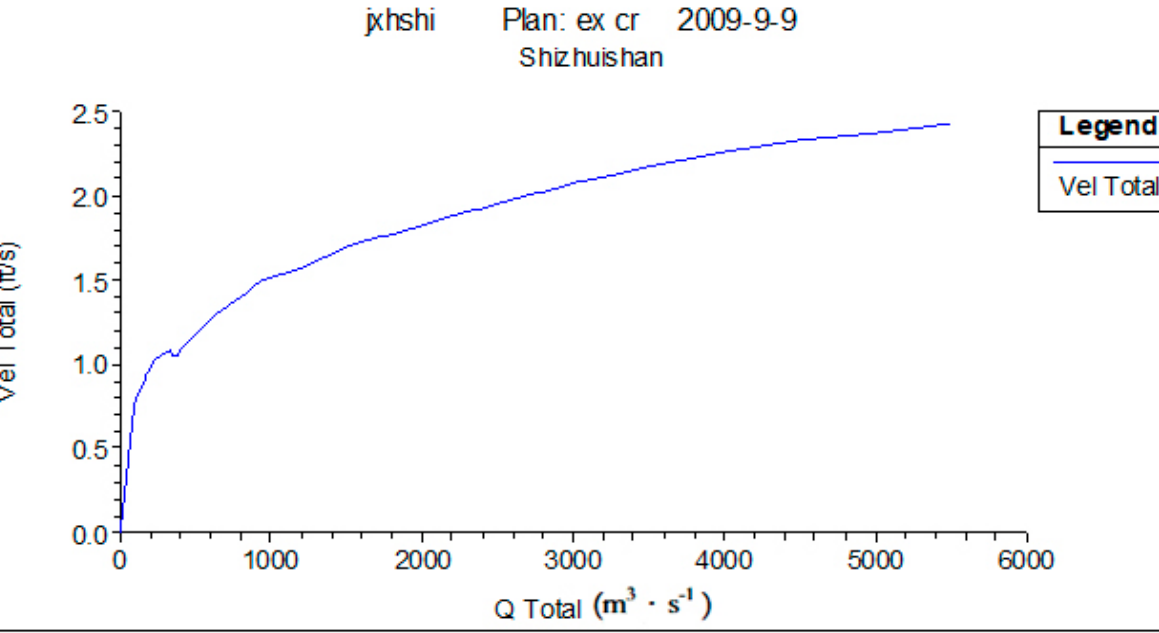
Figure 4. Flow velocity change at Shizuishan cross under different flows. Source: China Water Resources Yearbook, 2018.